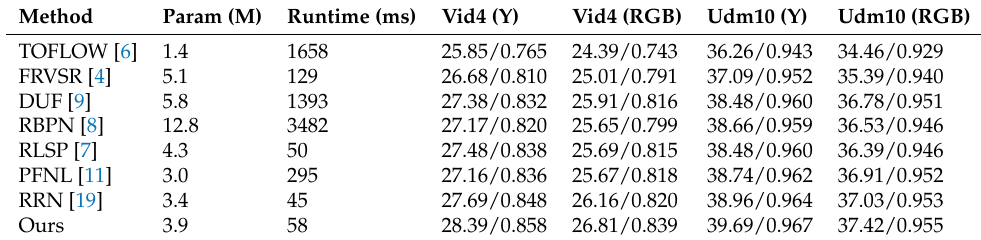
Table 3. Comparison of results with different methods in Vid4 and Udm10 datasets.